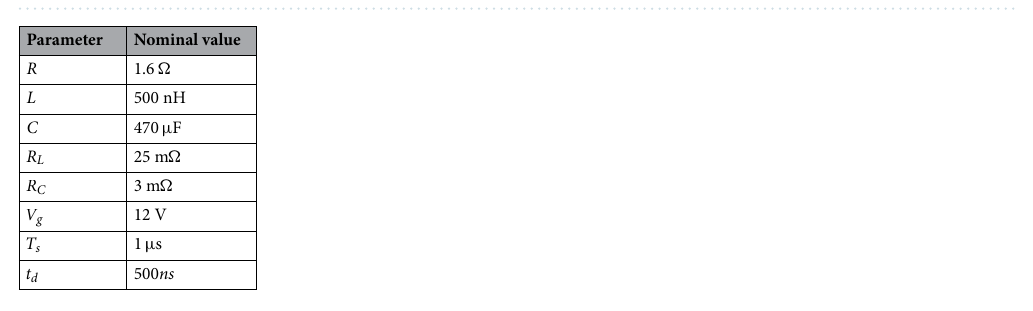
Table 2. Buck converter parameters with the respective nominal